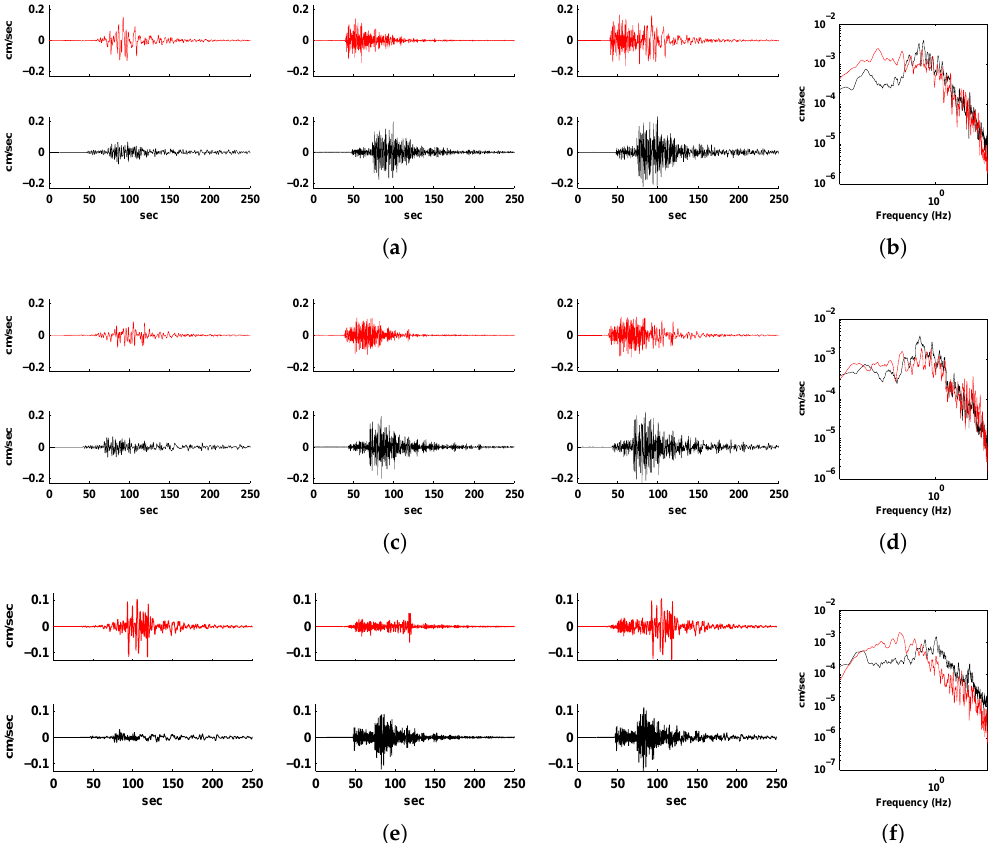
Figure 14. ( a ) North-south component, ( c ) east-west component, and ( e ) vertical component of ground velocity histories at Station 1. Shown in red are the long-period spectral-element-simulated (column 1), high-frequency EGF-synthesized (column 2), and combined broadband histories (column 3) for the 2004 Parkfield earthquake. Shown in black are the corresponding filtered observed ground velocity records for comparison. ( b , d , f ) show the comparison of the corresponding spectra of the broadband velocity histories (red: synthesized, black: